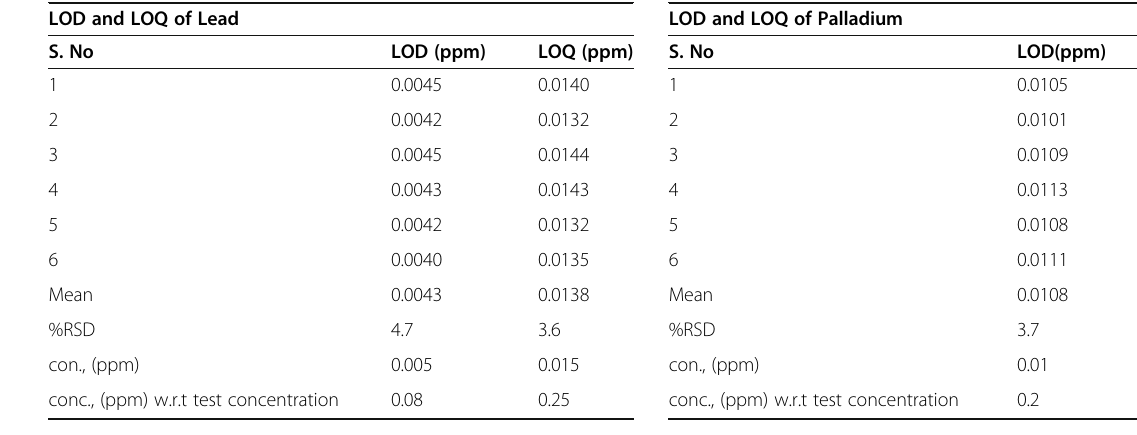
Table 4 LOD and LOQ experiments of